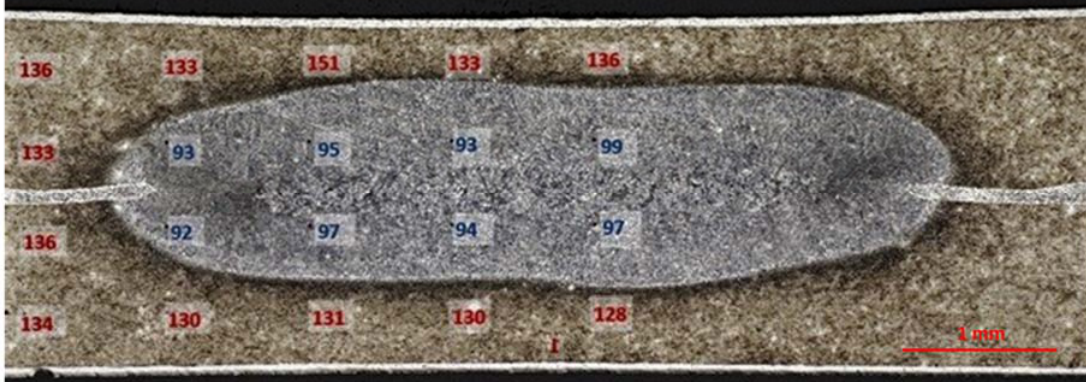
Figure 9. Microhardness of the resistance spot weld .